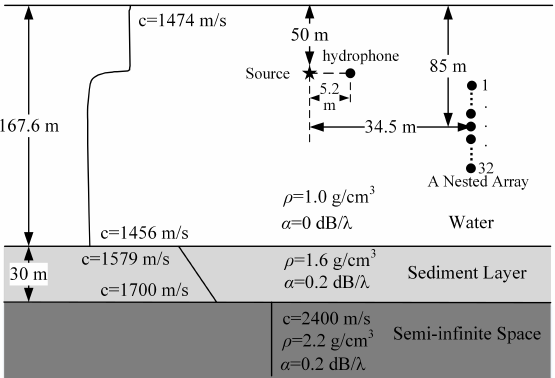
Figure 10. The sketch of the experimental reservoir environment and the arrangement of the source and the